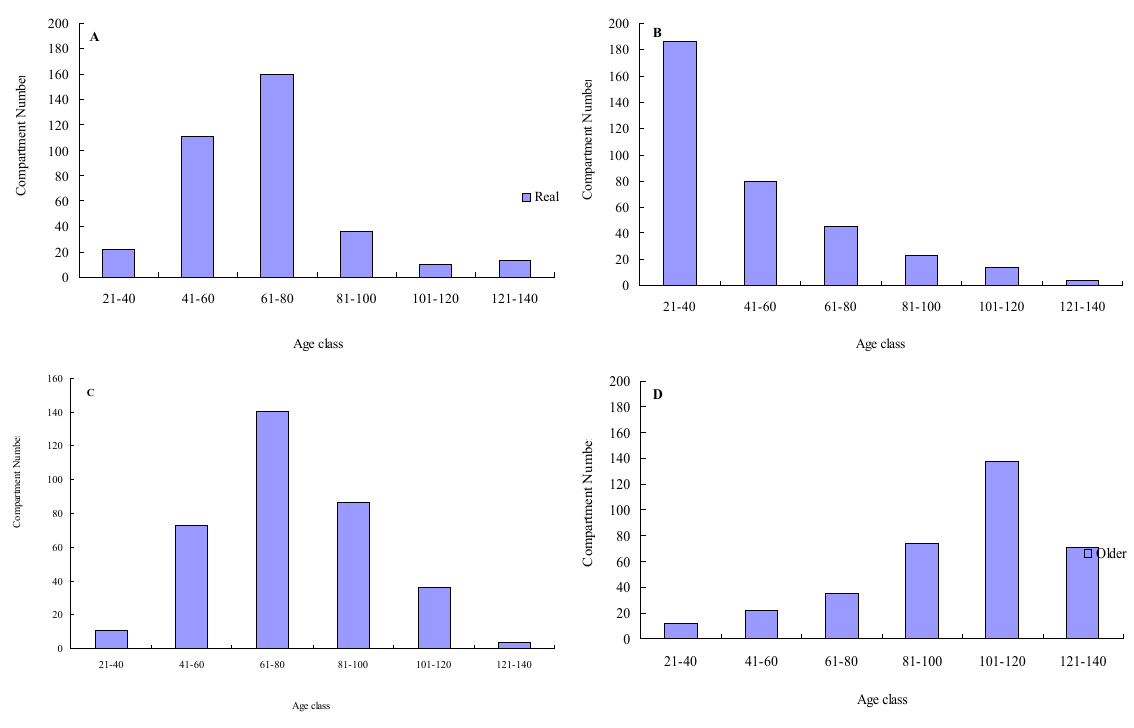
Figure 1. Age class distribution of one actual and three hypothetical forests in a 120,293 ha landscape in the northeast China; ( A ) actual forest; ( B ) young forest; ( C ) normal forest; ( D ) older